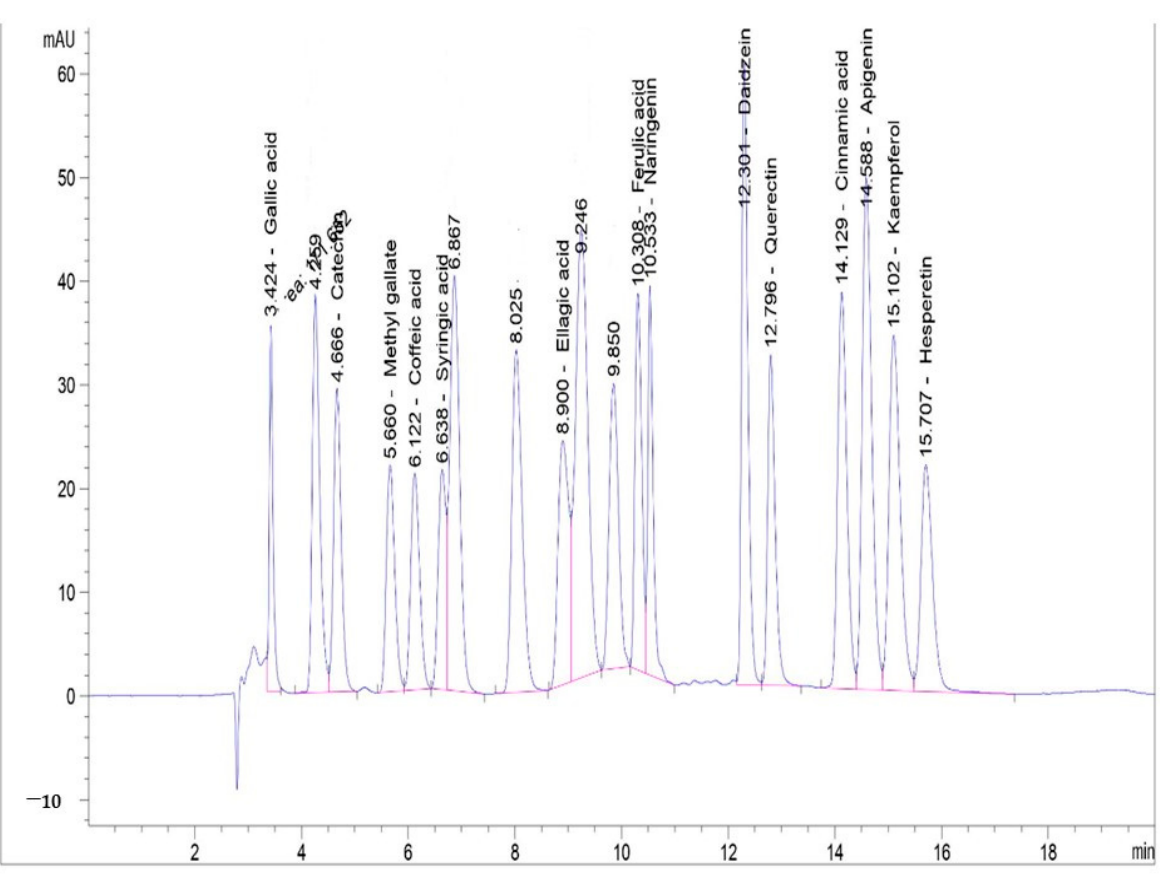
Figure 4. HPLC chromatogram of phenolic compounds profile of lyophilized HO algal extract. (1) Gallic acid, (3) Catechin, (4) Methyl gallate, (5) Caffeic acid, (6) Syringic acid, (9) Ellagic acid, (12) Ferulic acid, (13) Naringenin, (14) Daidzein, (15) Quercetin, (16) Cinnamic acid, (17) Apigenin, (18) Kaempferol, and (19)